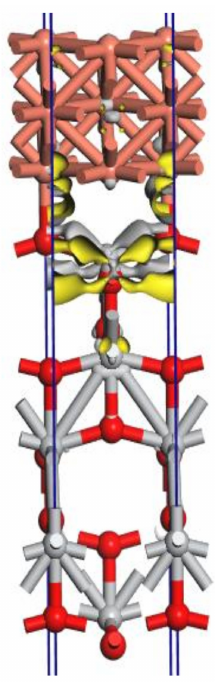
Figure 20. The charge density difference for the interface TiO 2 (001)-Cu(001) determined by DFT calculations (original design). It can be observed that copper (orange) forms coordinative bonds with oxygen at the surface of the TiO 2 crystal (Ti—grey, O—red) and causes an electron displacement (yellow), which would suggest these properties of copper-doped TiO 2